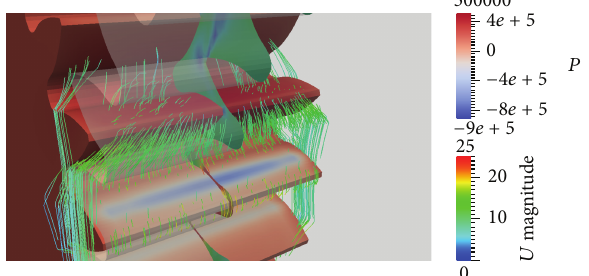
Figure 7: Detail of the